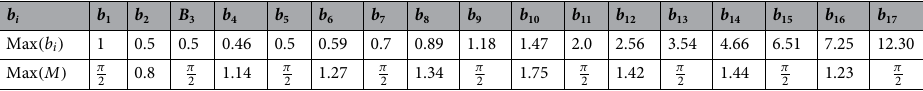
Table 1. The Extremum values and the corresponding extremum point of the coefficients.